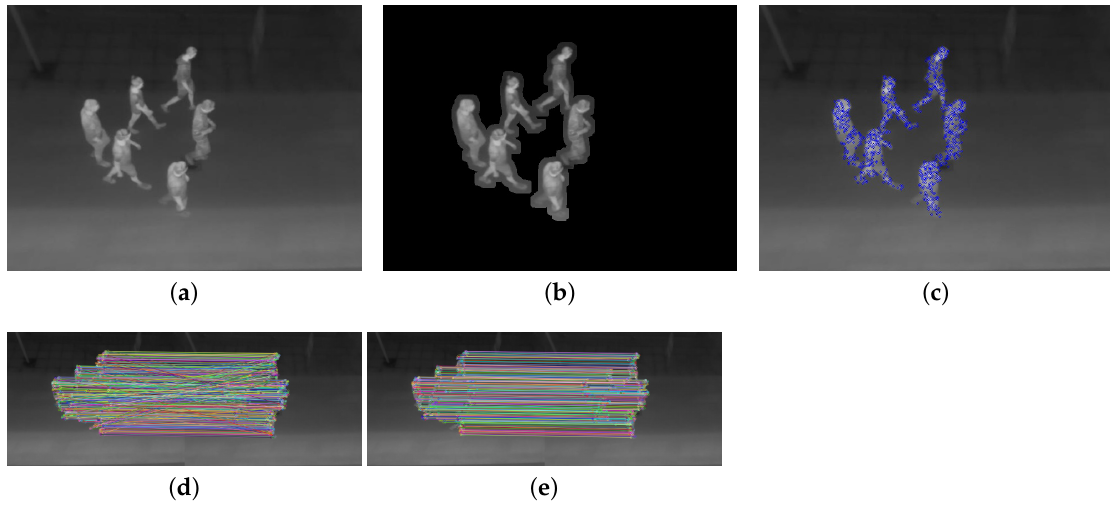
Figure 1. Example showing the extraction and matching of features in a thermal stereo image pair. ( a ) undistorted right input image; ( b ) applied foreground mask; ( c ) detected features; ( d ) matches; ( e ) matches with y -constraint. Note that (a)–(c) are performed for both the left and right images.